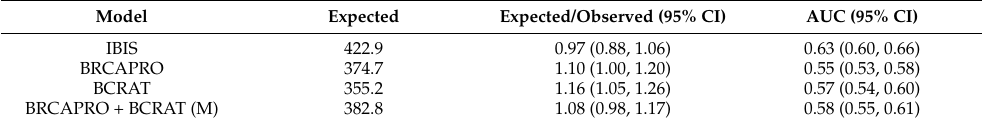
Table A8. Performance of IBIS, BRCAPRO, BCRAT, and BRCAPRO + BCRAT on simulated data.